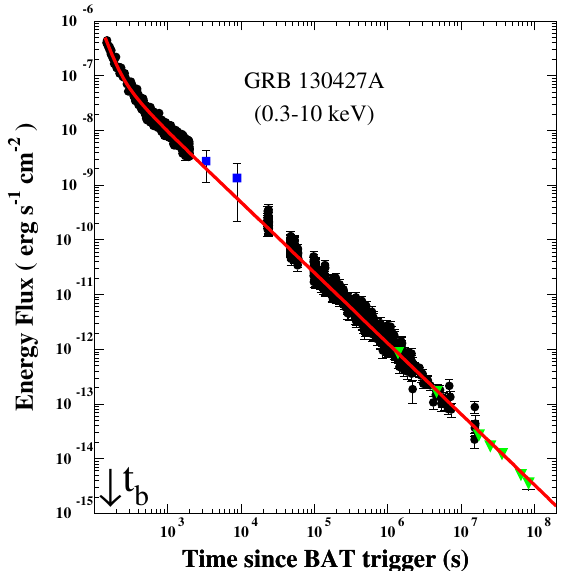
Figure 14. The X-ray light-curve of the intense GRB 130427A, measured with Swift XRT [95,96] (circles) and with XMM Newton and Chandra [97] (triangles) up to 83 Ms after burst, and its CB model best-fit with a start time and an early break hidden under the prompt emission phase. The two MAXI data points [98] (squares) at t = 3257 s and t = 8821 s are also shown. The best-fit power-law decline has an index α x = 1.29. The temporal decay index predicted by the CB model, Equation (14), for the measured spectral index [97] β x = 0.79 ± 0.03 is α x = 1.29 ±